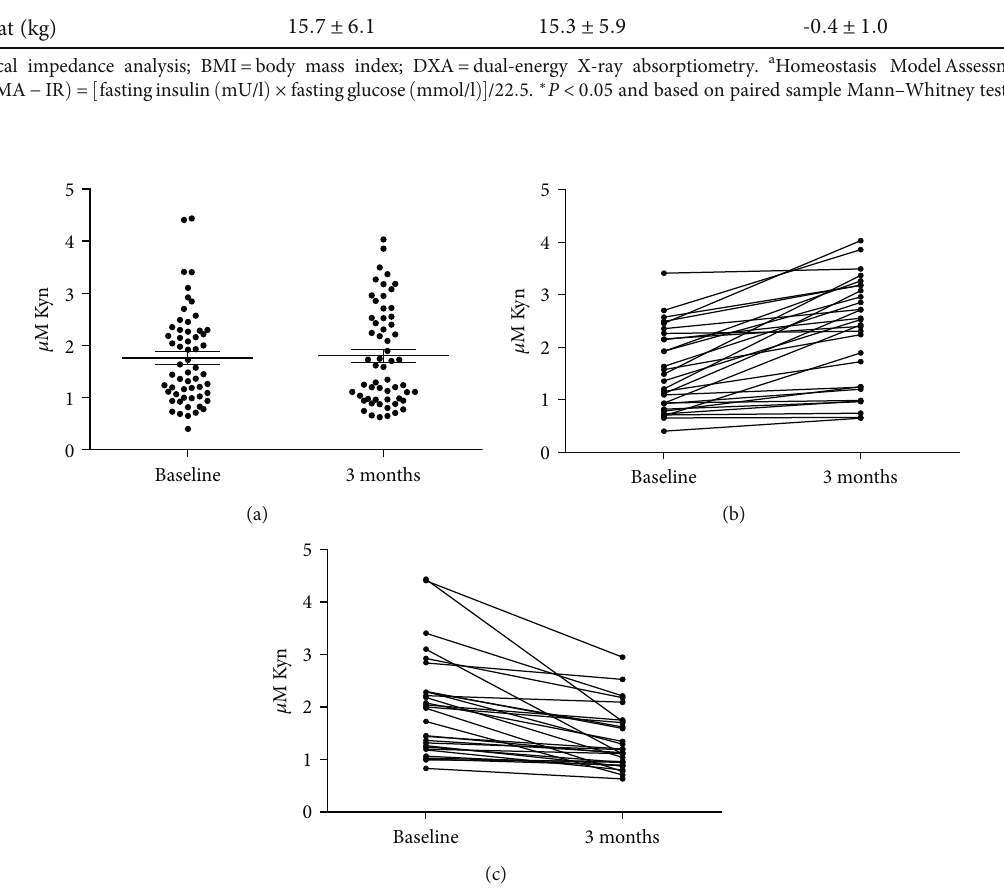
Table 2: Participant blood glucose, lipid, and body composition pro fi les at baseline and at three months ( n = 58 ). Baseline Three months Mean di ff erence P Mean ± SD Mean ± SD ± SD Fasting blood glucose (mg/dl)